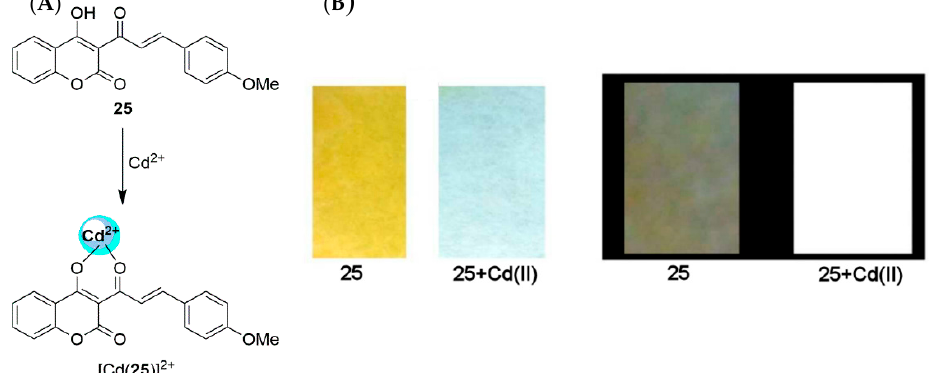
Figure 9. ( A ) Proposed binding between compound 25 and Cd 2 + ions and ( B ) photographs of colorimetric ( left ) and fluorometric ( right ) test kits. The filter papers were coated with 25 (0.1 mM) and then immersed into a HEPES-buffered solution (20 mM, CH 3 CH-H 2 O 3:7, v/v, pH 7). Adapted from [179] with permission from the Centre National de la Recherche Scientifique (CNRS) and the Royal Society of Chemistry. Table 2. The calculated concentration of Cd 2+ ions in cosmetics and personal care samples by fluorometric and atomic absorption spectroscopy (AAS) [179].